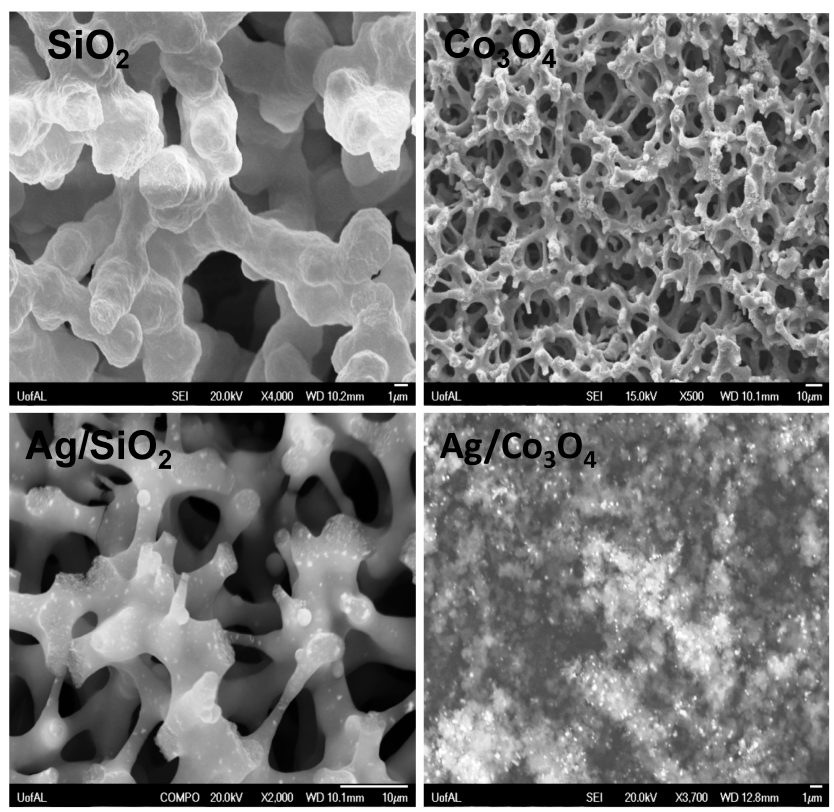
Figure 1. SEM images of monolithic